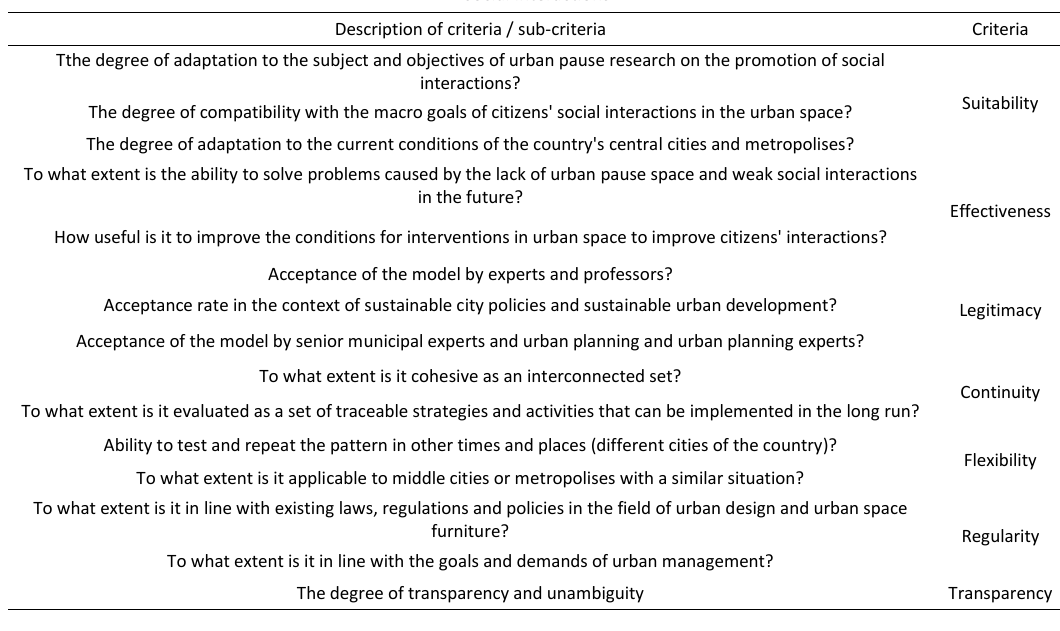
Table 7: Criteria for measuring the appropriateness and validity of the conceptual model of the role of urban pause space in promoting social interactions